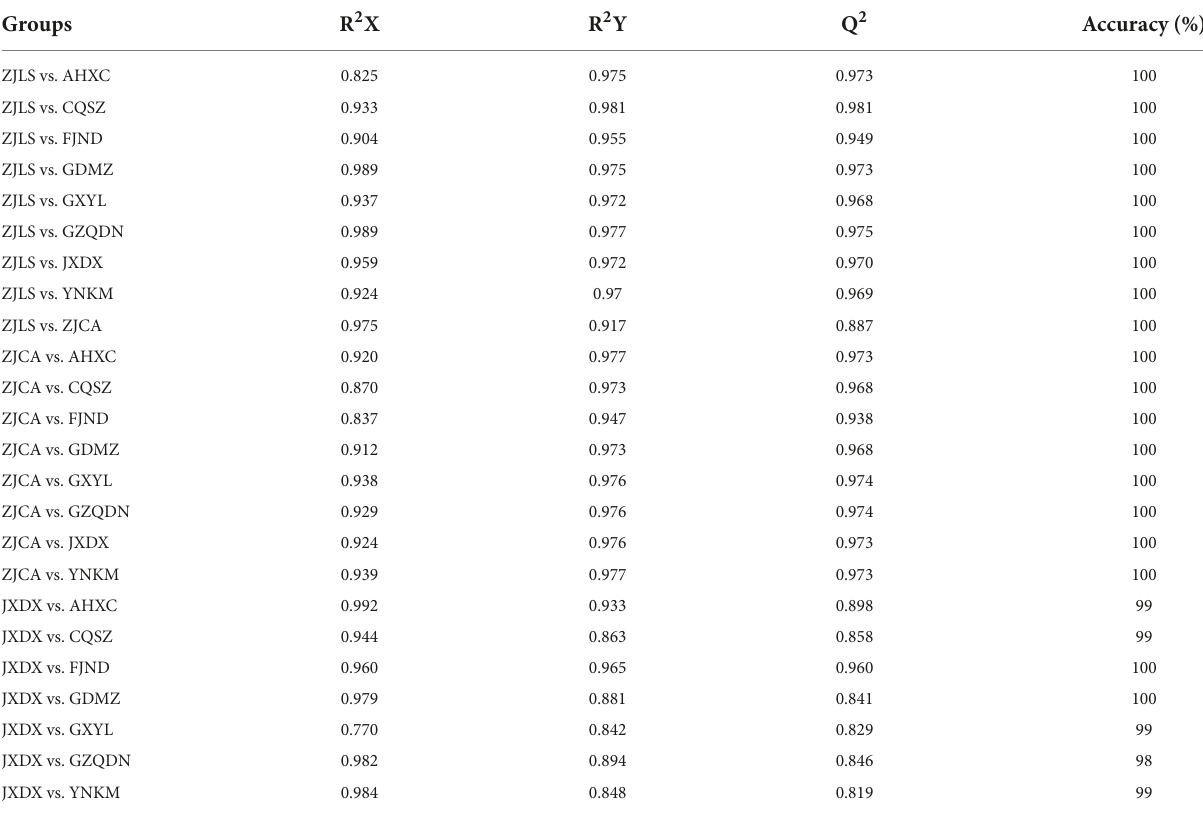
TABLE 4 Pairwise discrimination of fruits from PGI regions using the OPLSDA model.